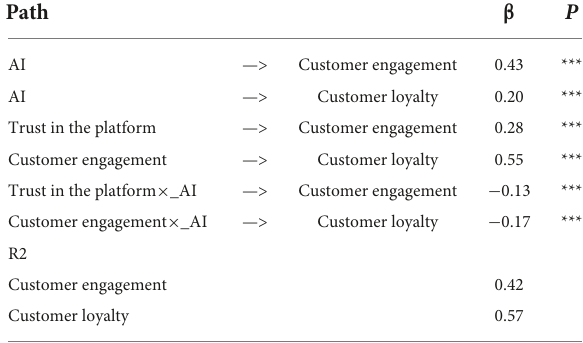
TABLE 8 Moderating test